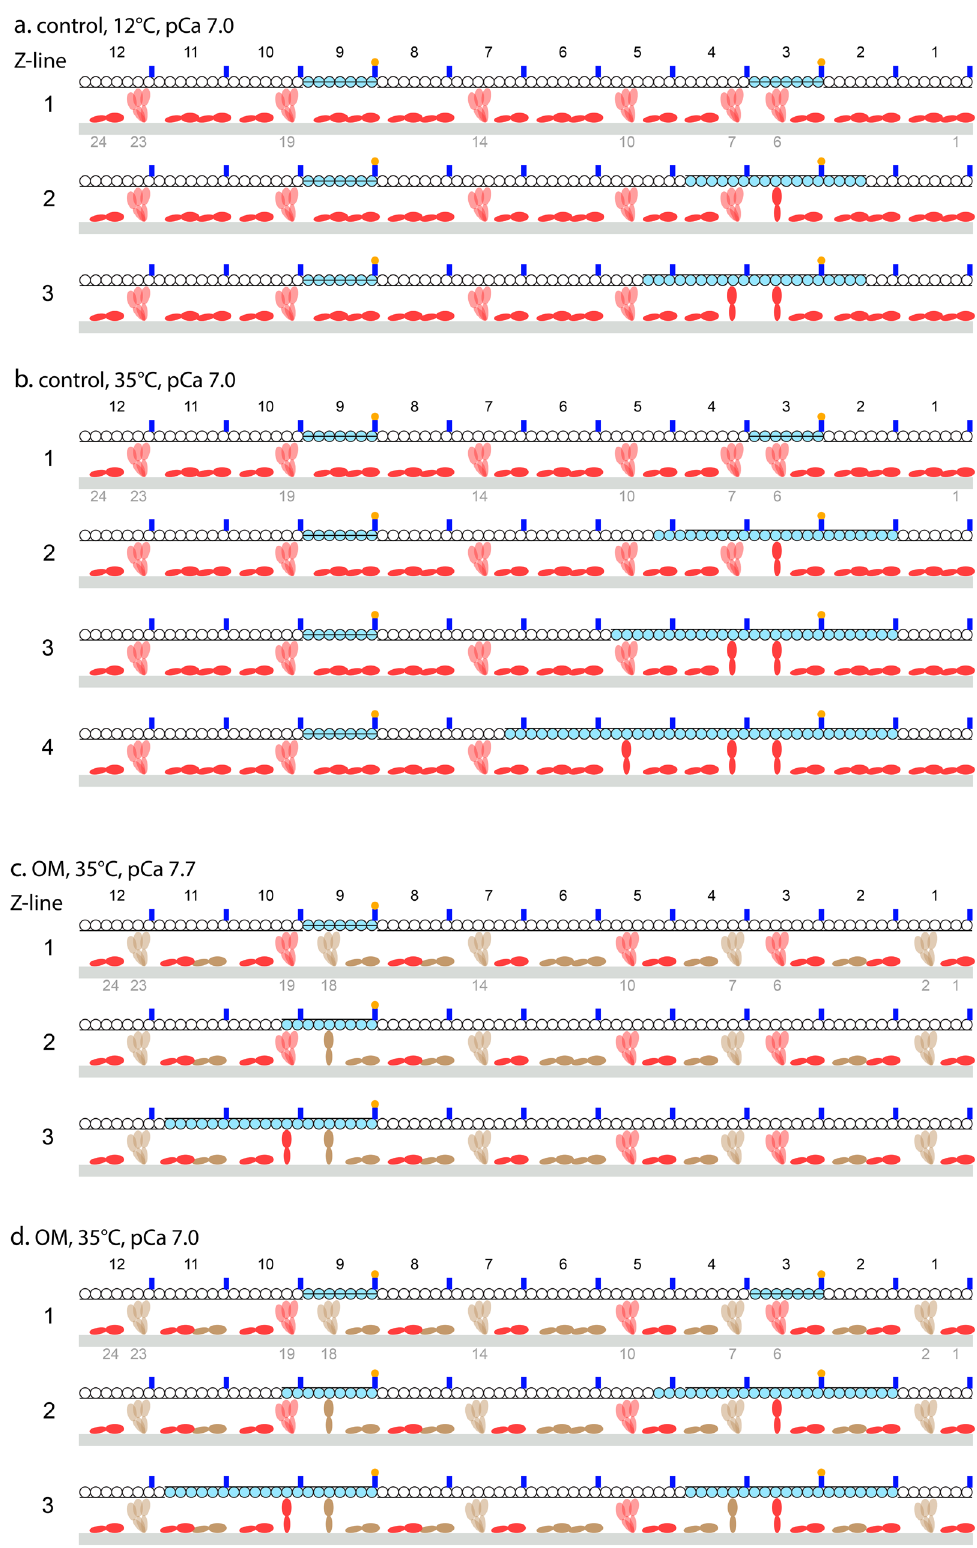
perature or protein isoform. As a corollary it can be seen that the corresponding n H − T 0 points belong to different relations depending on the myosin isoform (Supplementary Fig. 6,